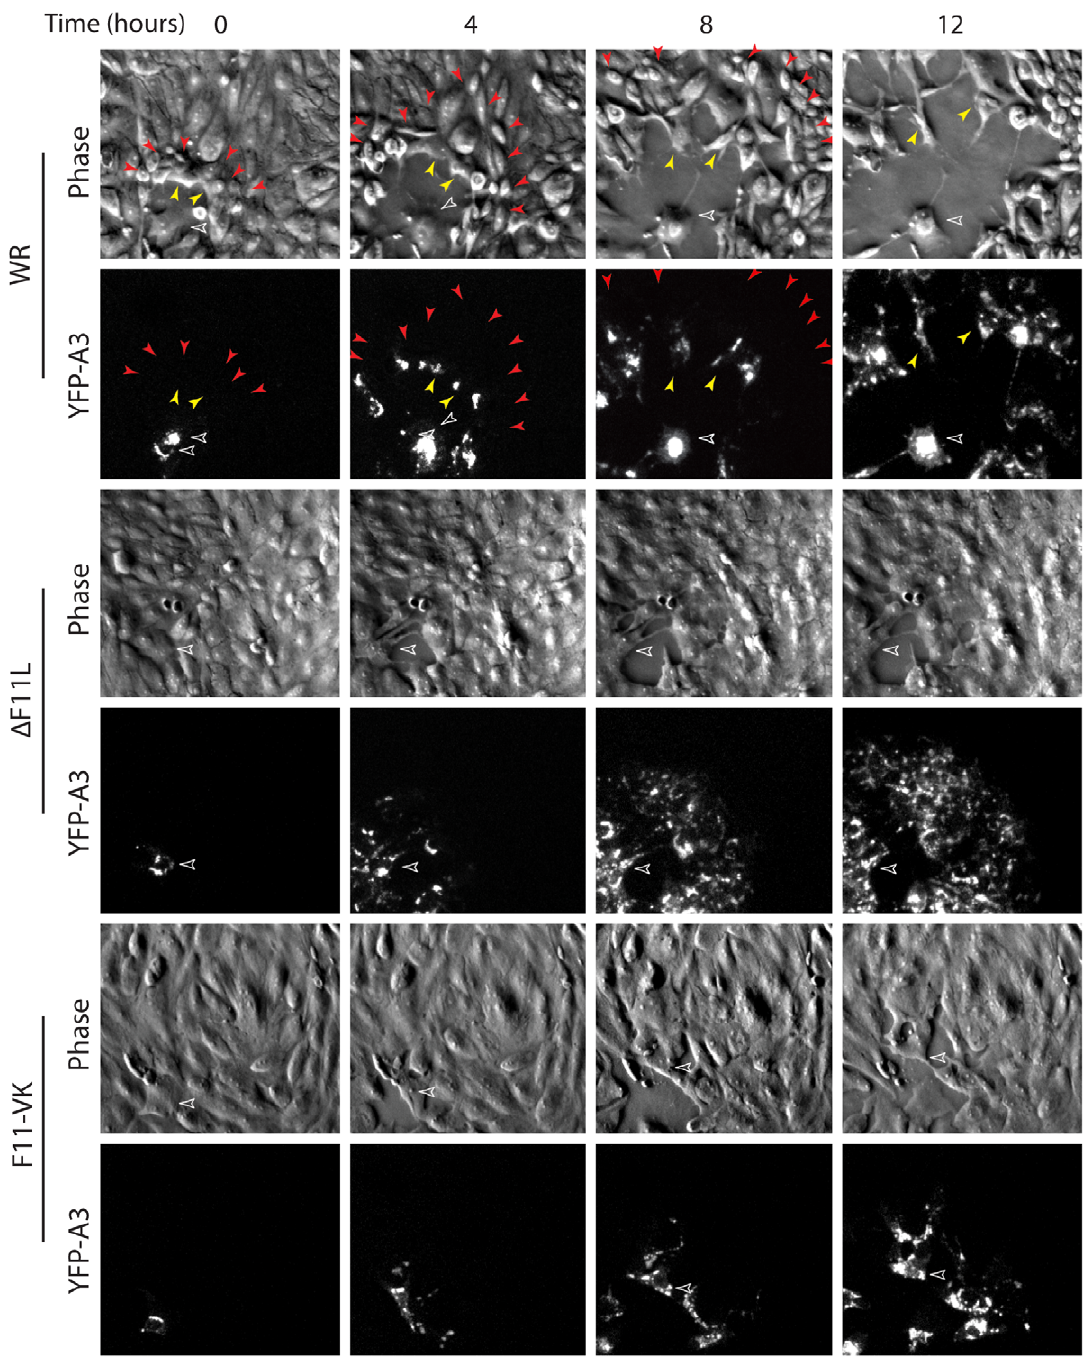
Figure 4. F11 promotes migration of infected cells. ( A ) Phase contrast and fluorescence movie stills at the indicated time of the leading edge of a developing plaque induced by WR expressing YFP-A3L. Yellow arrowheads highlight infected cells migrating away from the initial infected cell (open white arrowhead). Red arrowheads indicate cells that contract at the plaque front prior to moving (Movies S4, S5, S6).